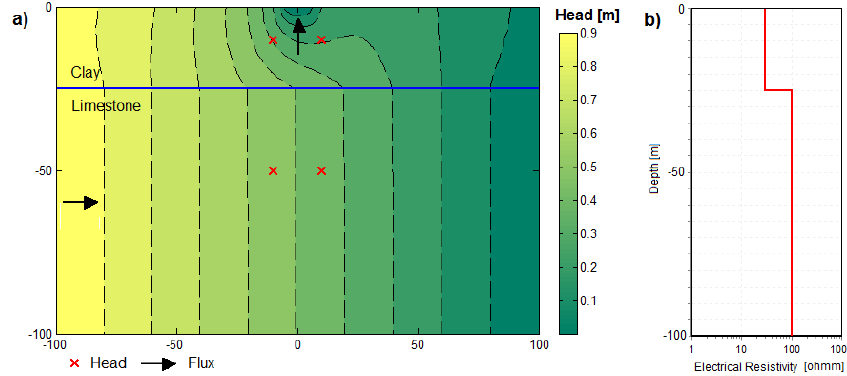
Fig. 2 Groundwater model (a), where red crosses mark head observations, black arrows represent the flux observations used for the JHI and SHI. The TDEM model (b) comprises a 1D, 2-layer electrical resistivity model.